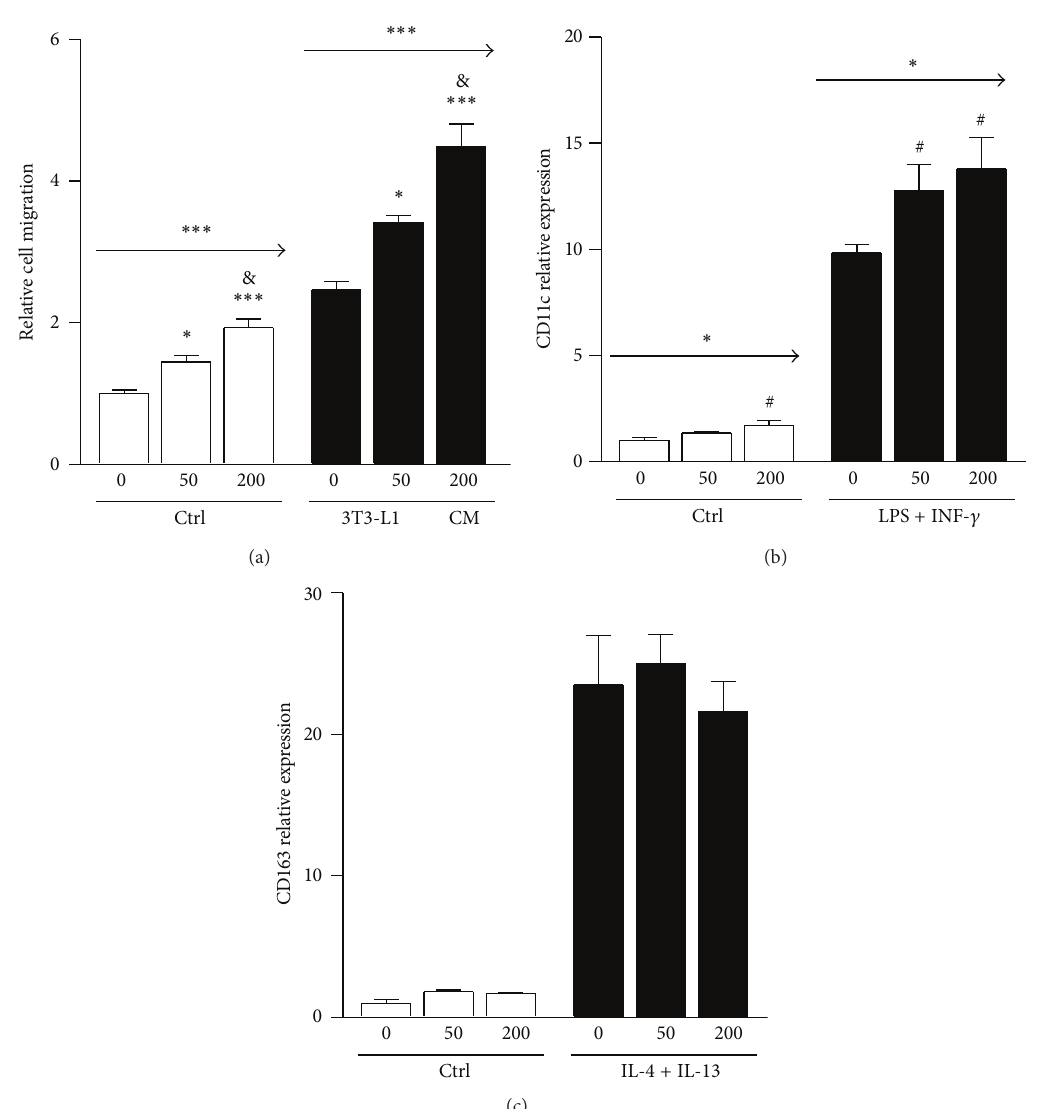
Figure 4: ASP induces proinflammatory effects in vitro . In (a), in vitro chemoattractive effects of three concentrations of ASP combined or not with adipocyte conditioned media on macrophages are shown. ASP effects on macrophage polarization to M1 phenotype are shown using M1 macrophage marker CD11c in (b) while ASP effects on M2 polarization are shown using M2 macrophage marker CD163 in (c). Results are expressed as relative expression or migration compared with Controls. Results are expressed as mean ± SEM where differences versus Control are expressed as # 𝑃 = 0.08 , ∗ 𝑃 < 0.05 , ∗∗ 𝑃 < 0.01 , ∗∗∗ 𝑃 < 0.001 , with 𝑛 = 4 . & are used in (a) to indicate a 𝑃 < 0.05 significant difference in between 200nM and 50 nM ASP concentration effect. Arrows are used to indicate a significant linear trend by ANOVA analysis where ∗ 𝑃 < 0.05 and ∗∗∗ 𝑃 < 0.001